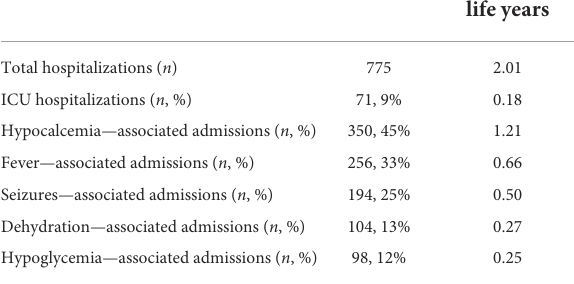
TABLE 1 Hospitalization characteristics of HRD patients in Soroka University Medical